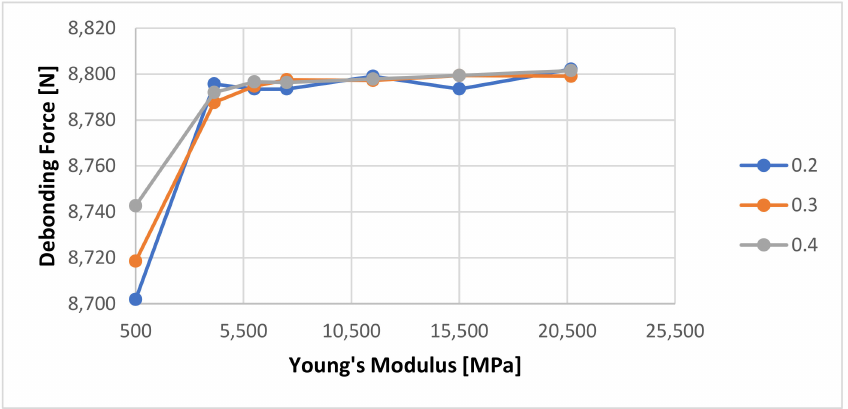
Figure 15. Detailed view of the calculated debonding force as a function of Young’s Modulus of the cement with a 1-day curing